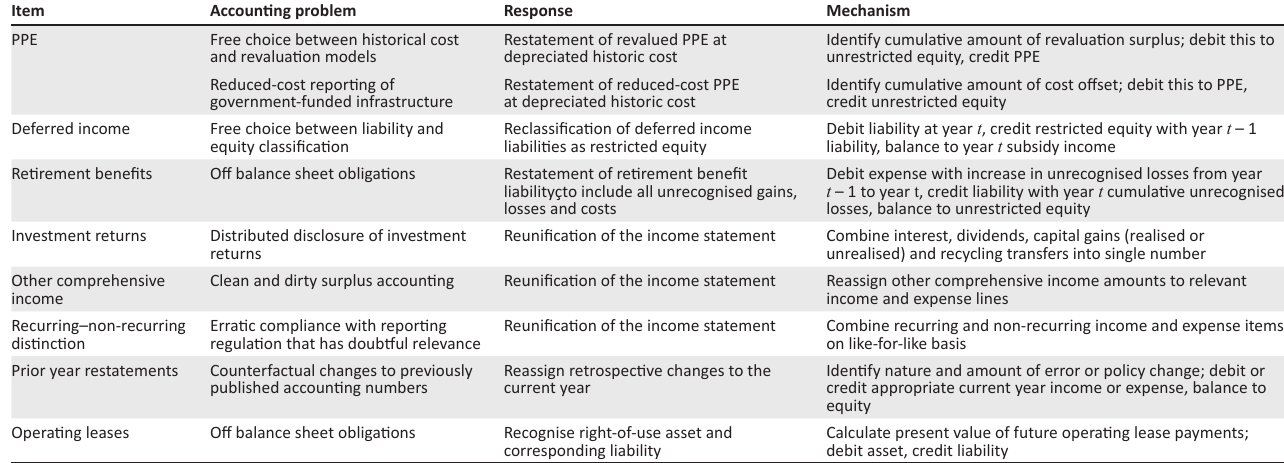
TABLE 5: Summarised accounting